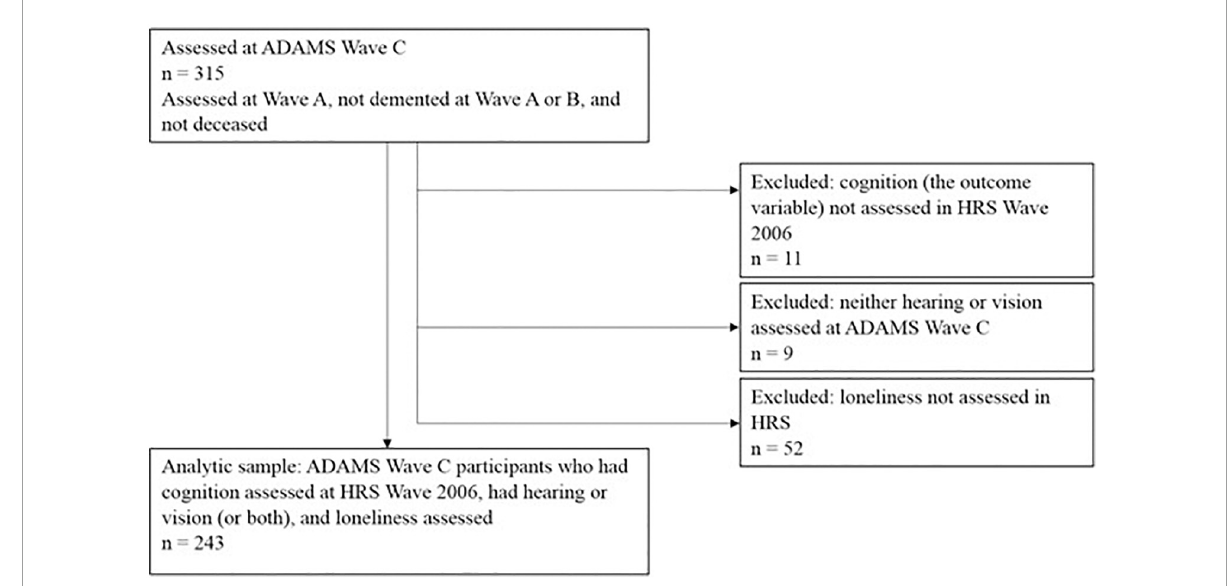
FIGURE1 Flow chart for deriving the analytical sample from Aging, Demographics, and Memory Study (ADAMS) Wave